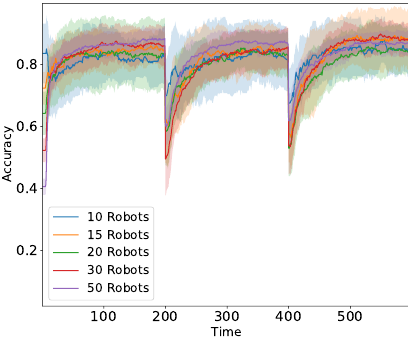
Figure 15. Temporal evolution of the accuracy of the robot’s classification in the borderline identifica- tion experiment for diverse swarm sizes. Every 200 time steps the swarm topology is changed while the neural states are preserved. The darker curves represent the median of the accuracy using all 50 collected samples. Alternatively, the clearer areas indicate, at each time instant, the first and third quantiles of the accuracies.